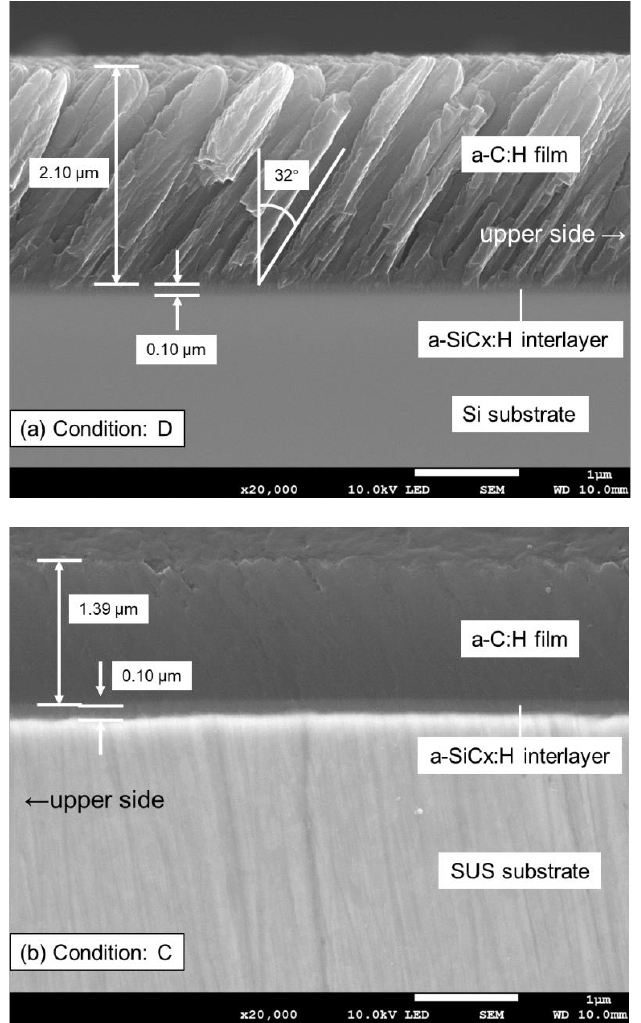
Figure 6. Cross-sectional SEM image at a trench depth of 2 mm of ( a ) Si/Carbon ion implantation/a- SiCx:H/a-C:H and ( b ) SUS430/a-SiCx:H/a-C:H